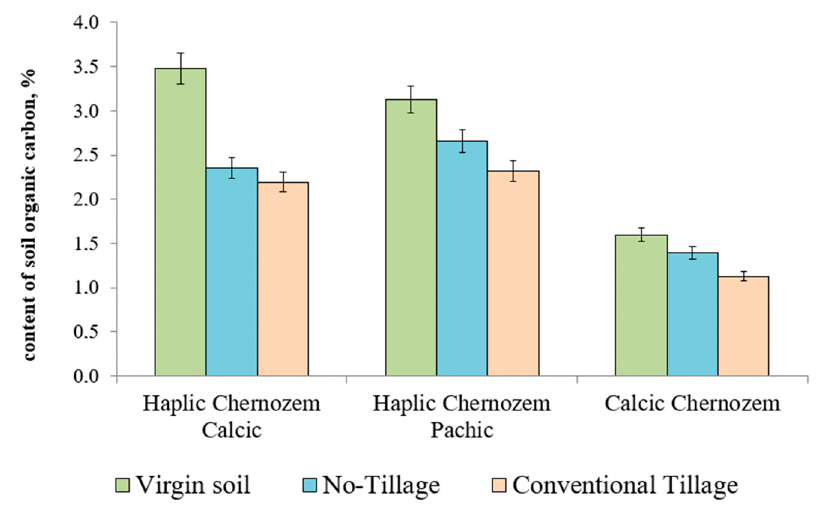
Figure 3. Comparative analysis of the SOC content in the upper soil layer during NT and CT versus VS (%).